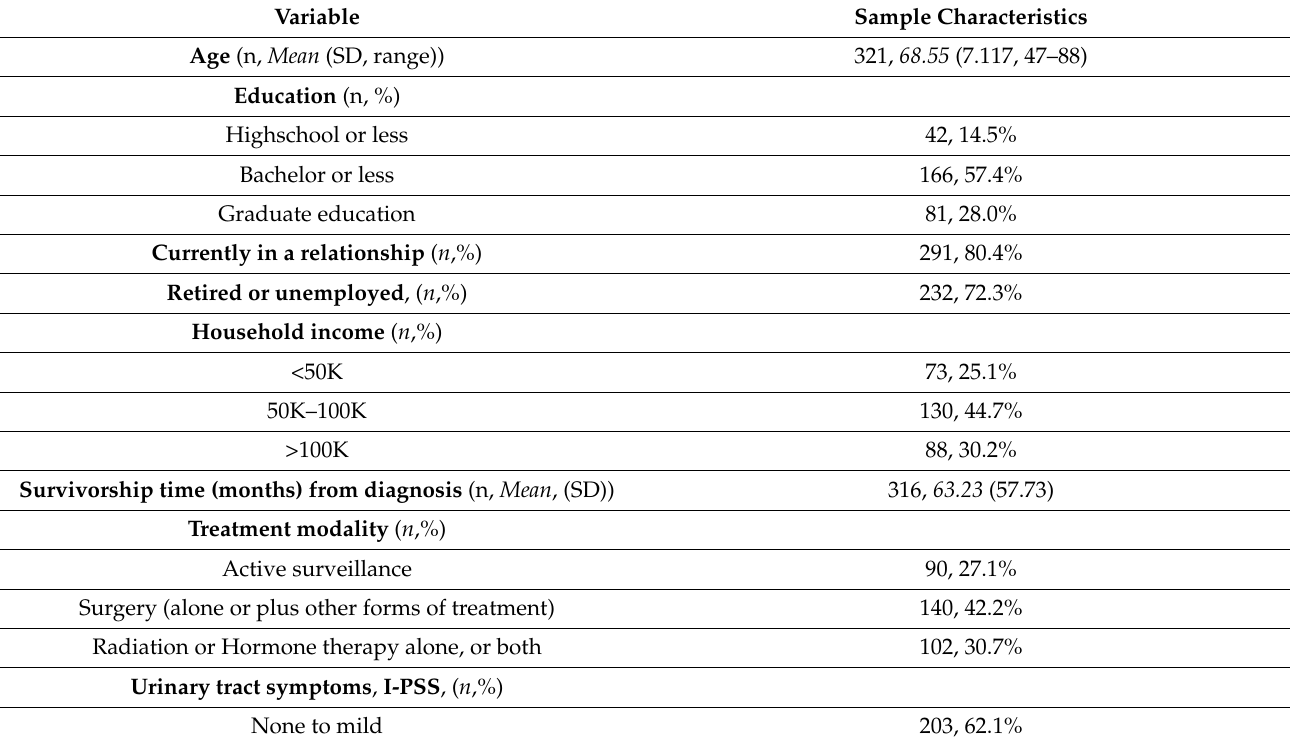
Table 1. Demographic characteristics of a sample of men with a history of prostate cancer diagnosis from the baseline cycle of a Quality-of-Life Maritimes Survey administered between 2017 and 2021, n =